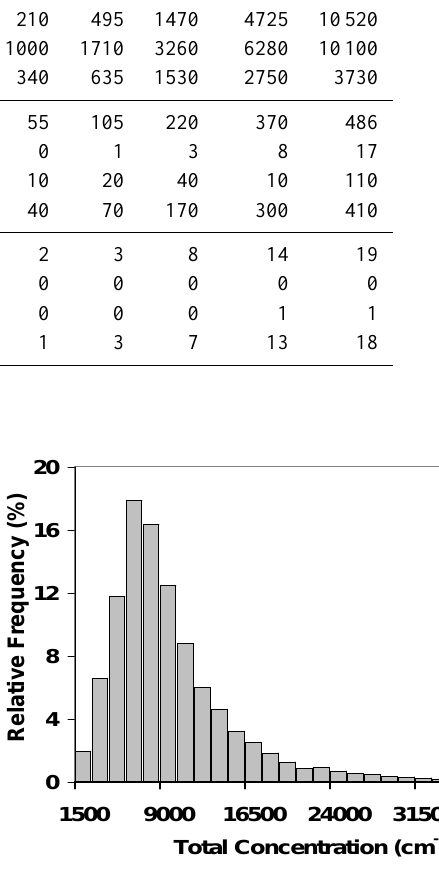
Fig. 2. The relative occurrence frequencies of total particle concen- trations of 1-h data for the two-year period under